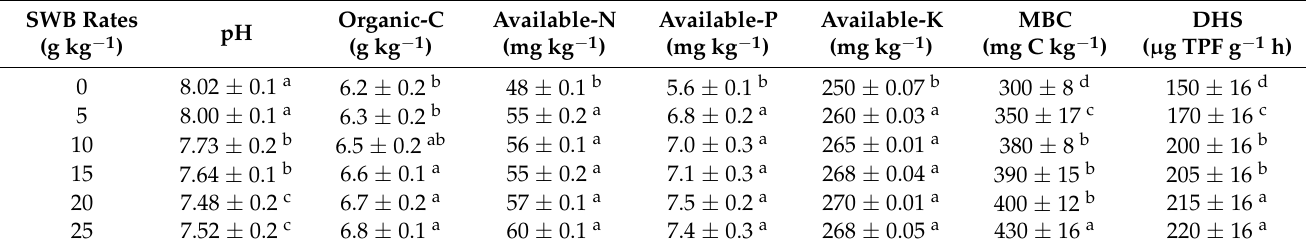
Table 3. Effect of SWB on soil quality.